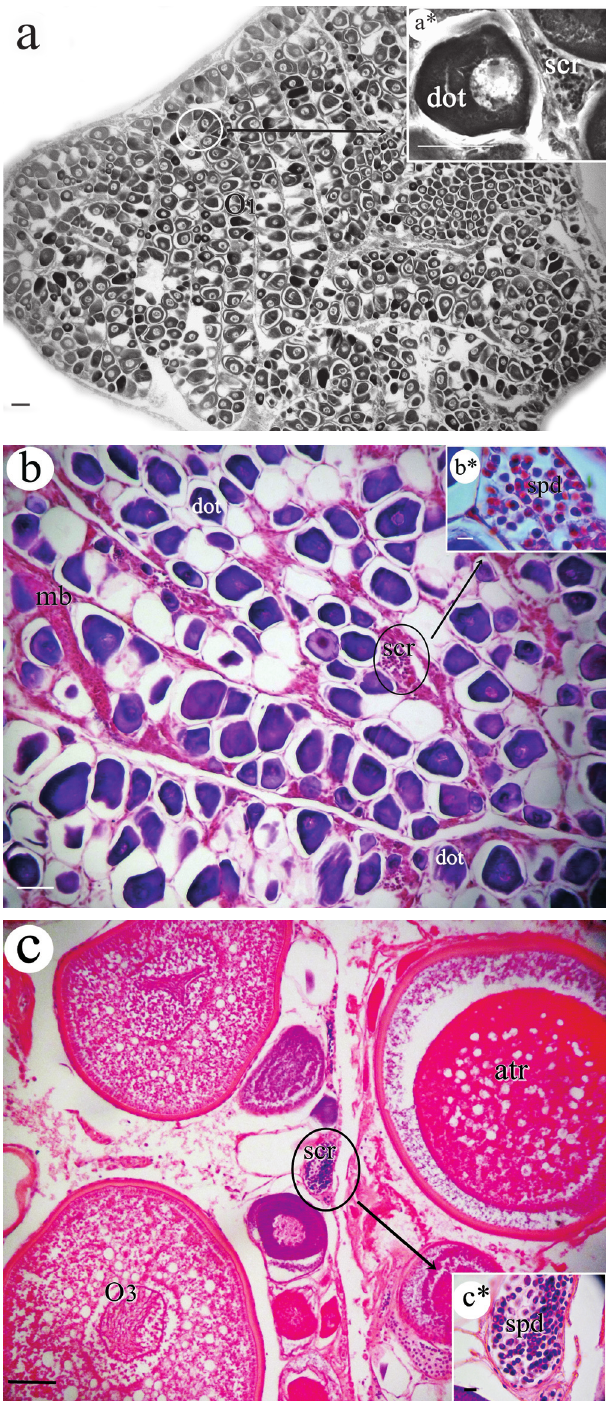
Fig. 4. (left column) Females with bisexual and transitional phases in Alphestes afer . (a) Section showing a gonad in bisexual phase of immature female (bar = 50 μ m) (16.1 cm T ; L May 2008). (a*) Detail of spermatic crypt in major magnification of same specimen (1000x; bar = 20 μ m). (b) Section showing a gonad in transitional phase of resting female with sperm crypts spread among ovarian tissue (bar = 50 μ m) (19.8 cm T ; May L 2009). (b*) Detail of spermatic crypt (1000x; bar = 2 μ m). (c) Section of ovary showing transitional phase of spent female with sperm crypts around vitellogenic stage oocyte (bar = 50 μ m) (21.1 cm T ; October 2009). (c*) Detail of spermatic crypt L (1000x, bar = 2 μ m) O = primary growth stage oocyte; dot = 1 degenerating ovarian tissue, scr = sperm crypts; mb = muscle boundle; O3 = vitellogenic stage oocyte; atr = atretic vitellogenic oocytes; spd =